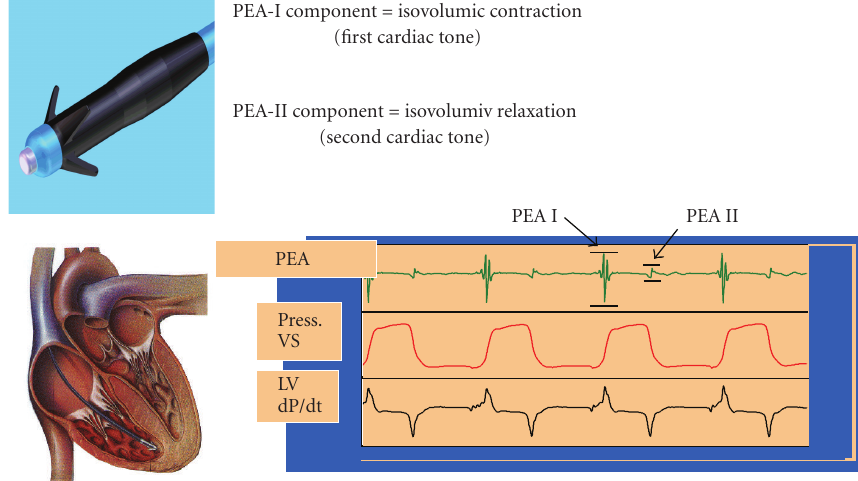
Figure 1: Peak Endocardial Acceleration (PEA) sensor (Sorin Group, Italy). An accelerometer mounted on the tip of a pacing lead placed in the right ventricle detects PEA-I, related to the isovolumic contraction (and the first cardiac tone) and PEA-II, related to the isovolumic relaxation (and the second cardiac tone).